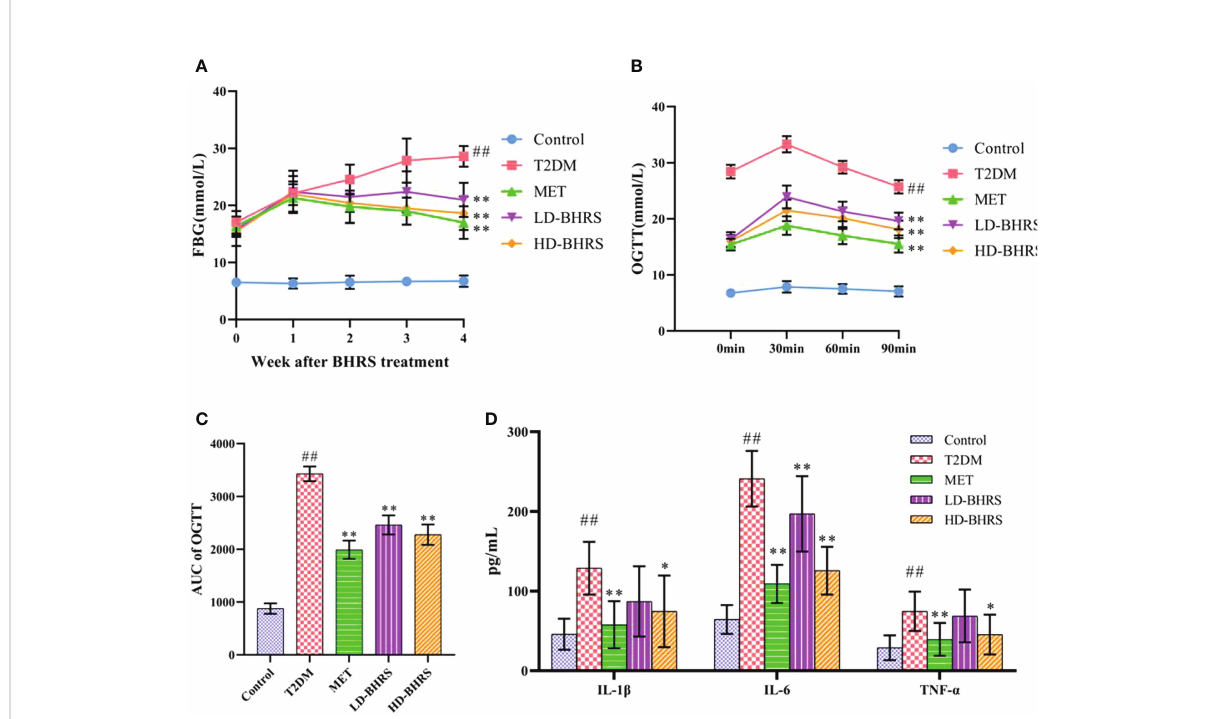
FIGURE 1 BHRS treatment decreased the levels of fasting blood glucose (FBG), lowered the area under the curve (AUC) of oral glucose tolerance test (OGTT) and reduced the serum levels of pro-in fl ammatory cytokines (IL-1 b , IL-6 and TNF- a ). (A) FBG of each group. (B, C) OGTT and OGTT- AUC of each group. (D) Serum pro-in fl ammatory cytokines of each group. ## : p < 0.01 as compared to the control group; *: p < 0.05 as compared to the T2DM group; **: p < 0.01 as compared to the T2DM